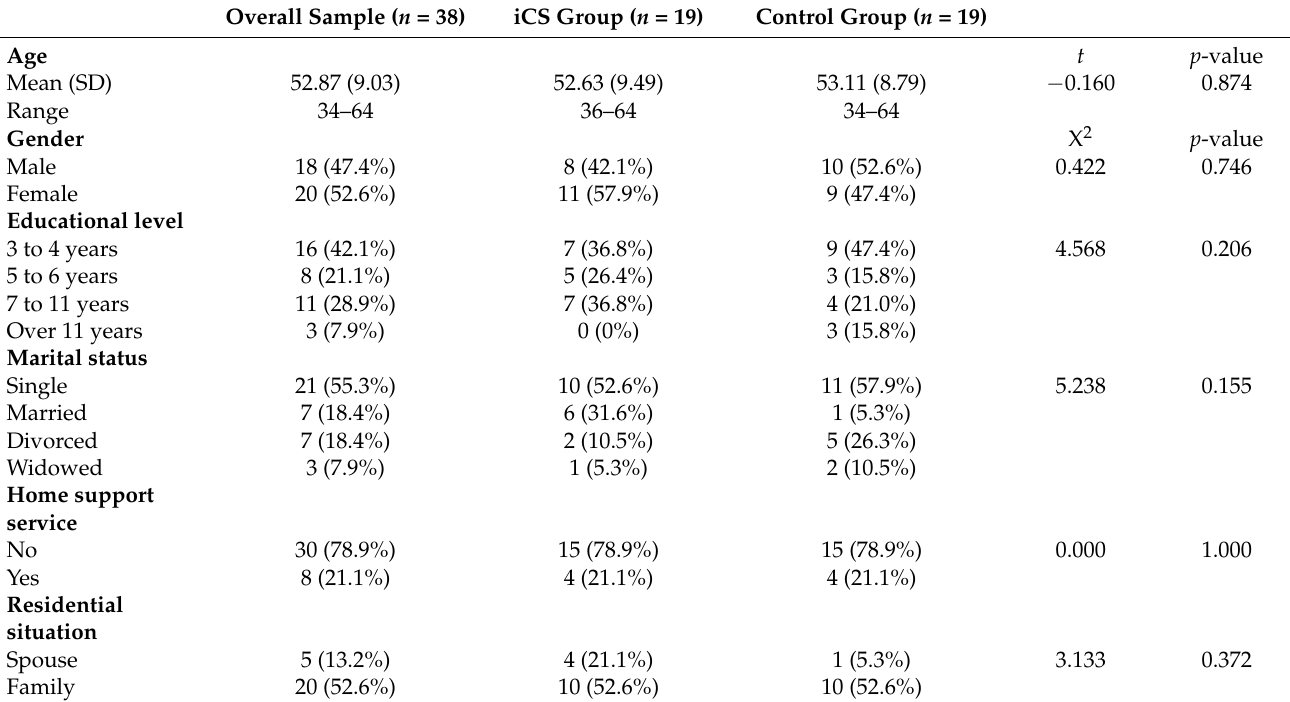
Table 1. Sociodemographic and clinical characteristics of the sample, and the results of the between- group